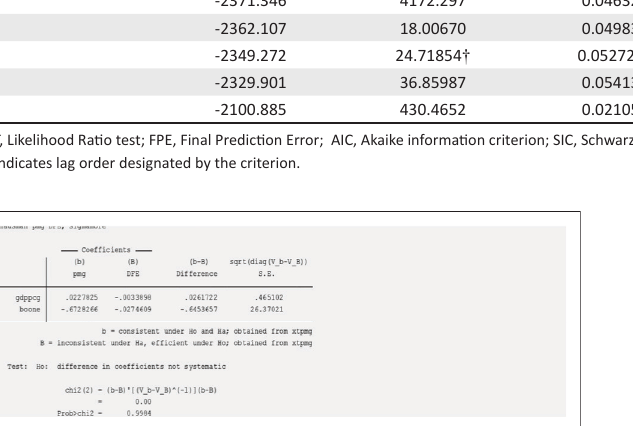
FIGURE 1-A1: Hausman test results.